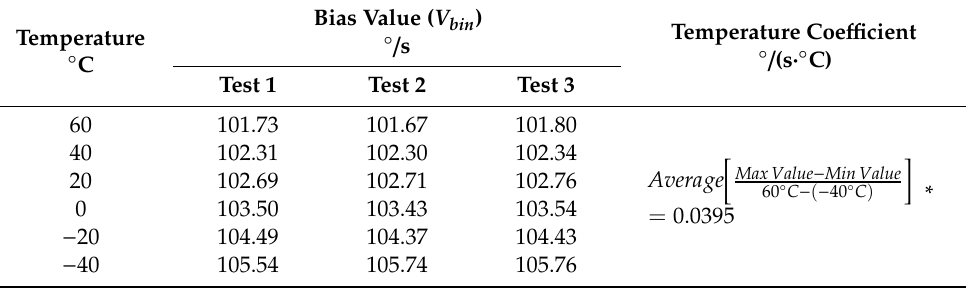
Table 4. MEMS gyroscope temperature bias coe ffi cient test result.